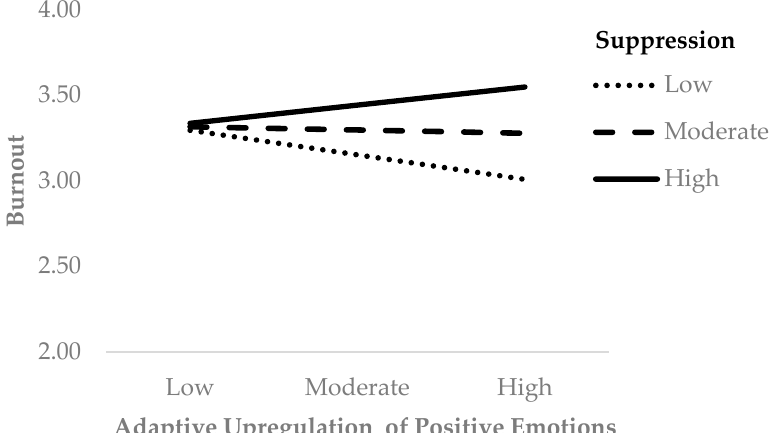
Figure 1. Adaptive upregulation of positive emptions predicting burnout as a function of suppression.